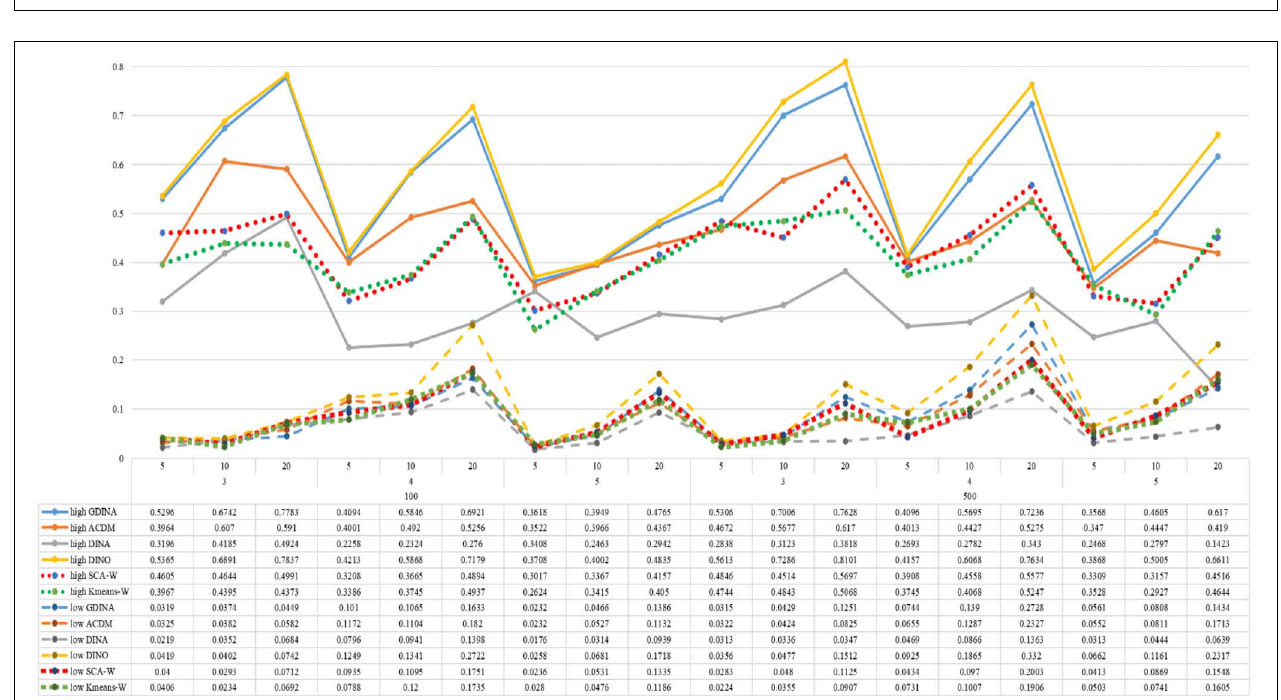
FIGURE 7 | Mean values of ARI by SCA, K-means, and fitted models; True model = DINO.